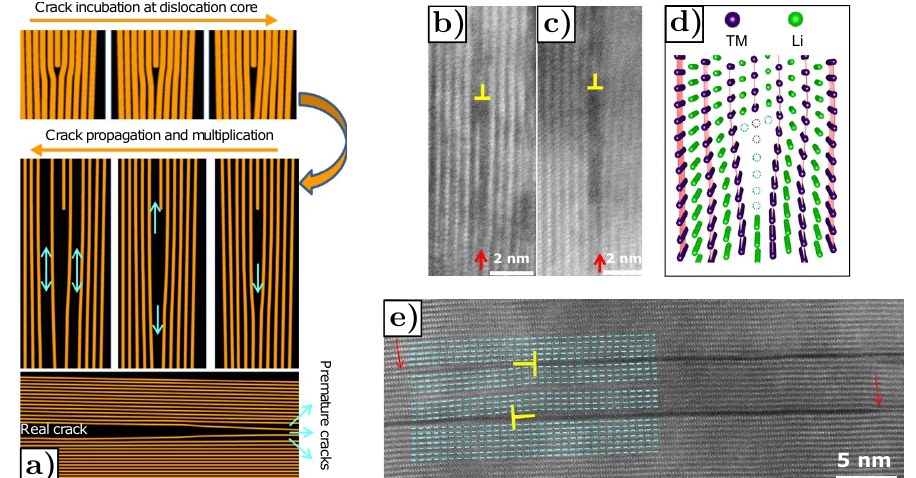
Figure 22. ( a ) Schematic diagrams of the dislocation-assisted crack incubation, propagation and multiplication process in NMC cathode particles. ( b , c ) Nucleation of premature cracks at the dis- location core in NMC333 cycled particles, also schematized in ( d ). ( e ) Edge dislocations associated with intragranular cracks in cycled NMC333 particles. Crack tip is indicated with the red arrows. Reprinted with permission from Springer Nature by [108], Copyright 2017.